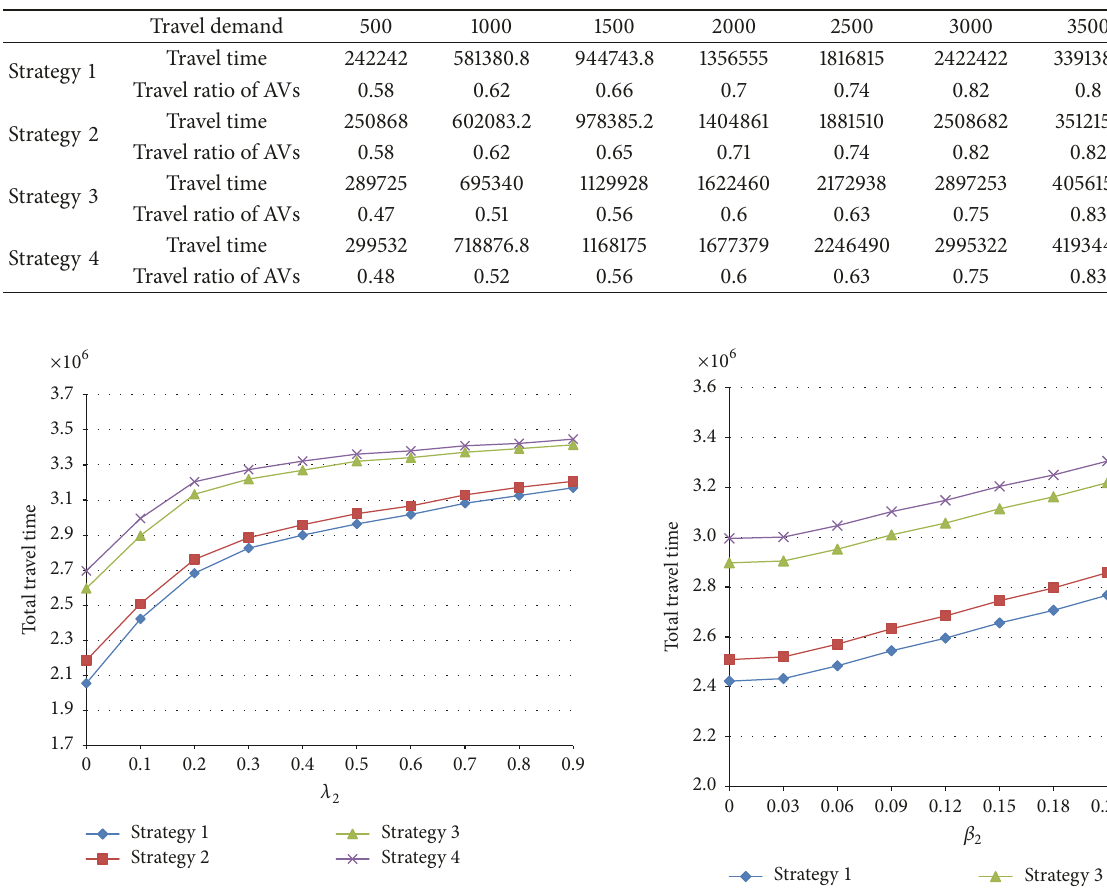
Figure 9: Relation between 𝜆 2 and total travel time.